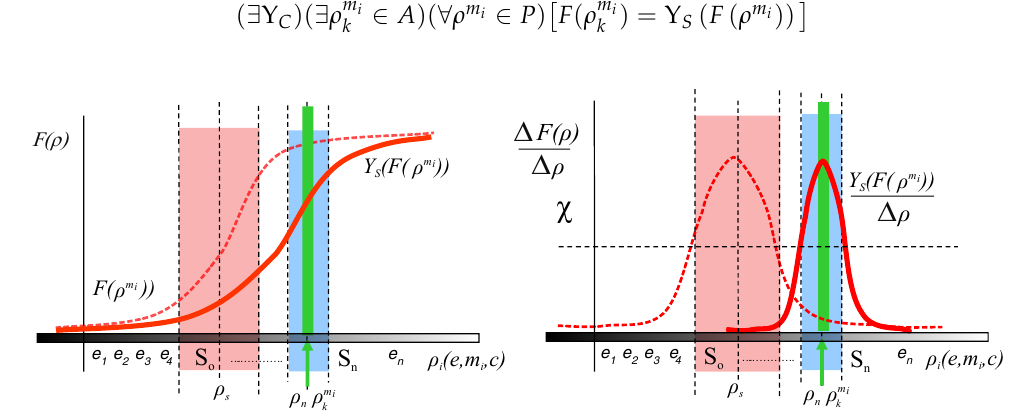
Figure 4. Outline for a transformation Υ S shifting the tuning point to the working point ρ m i curve and light red area represents the old calibration and S o respectively. Red line curve and blue area represent the new calibration curve and the new S n . The old tuning point ρ s has been consequently moved to the new one ρ n after transformation is applied.